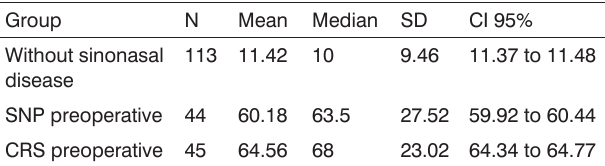
Table 2. Comparison of pre-op scores.